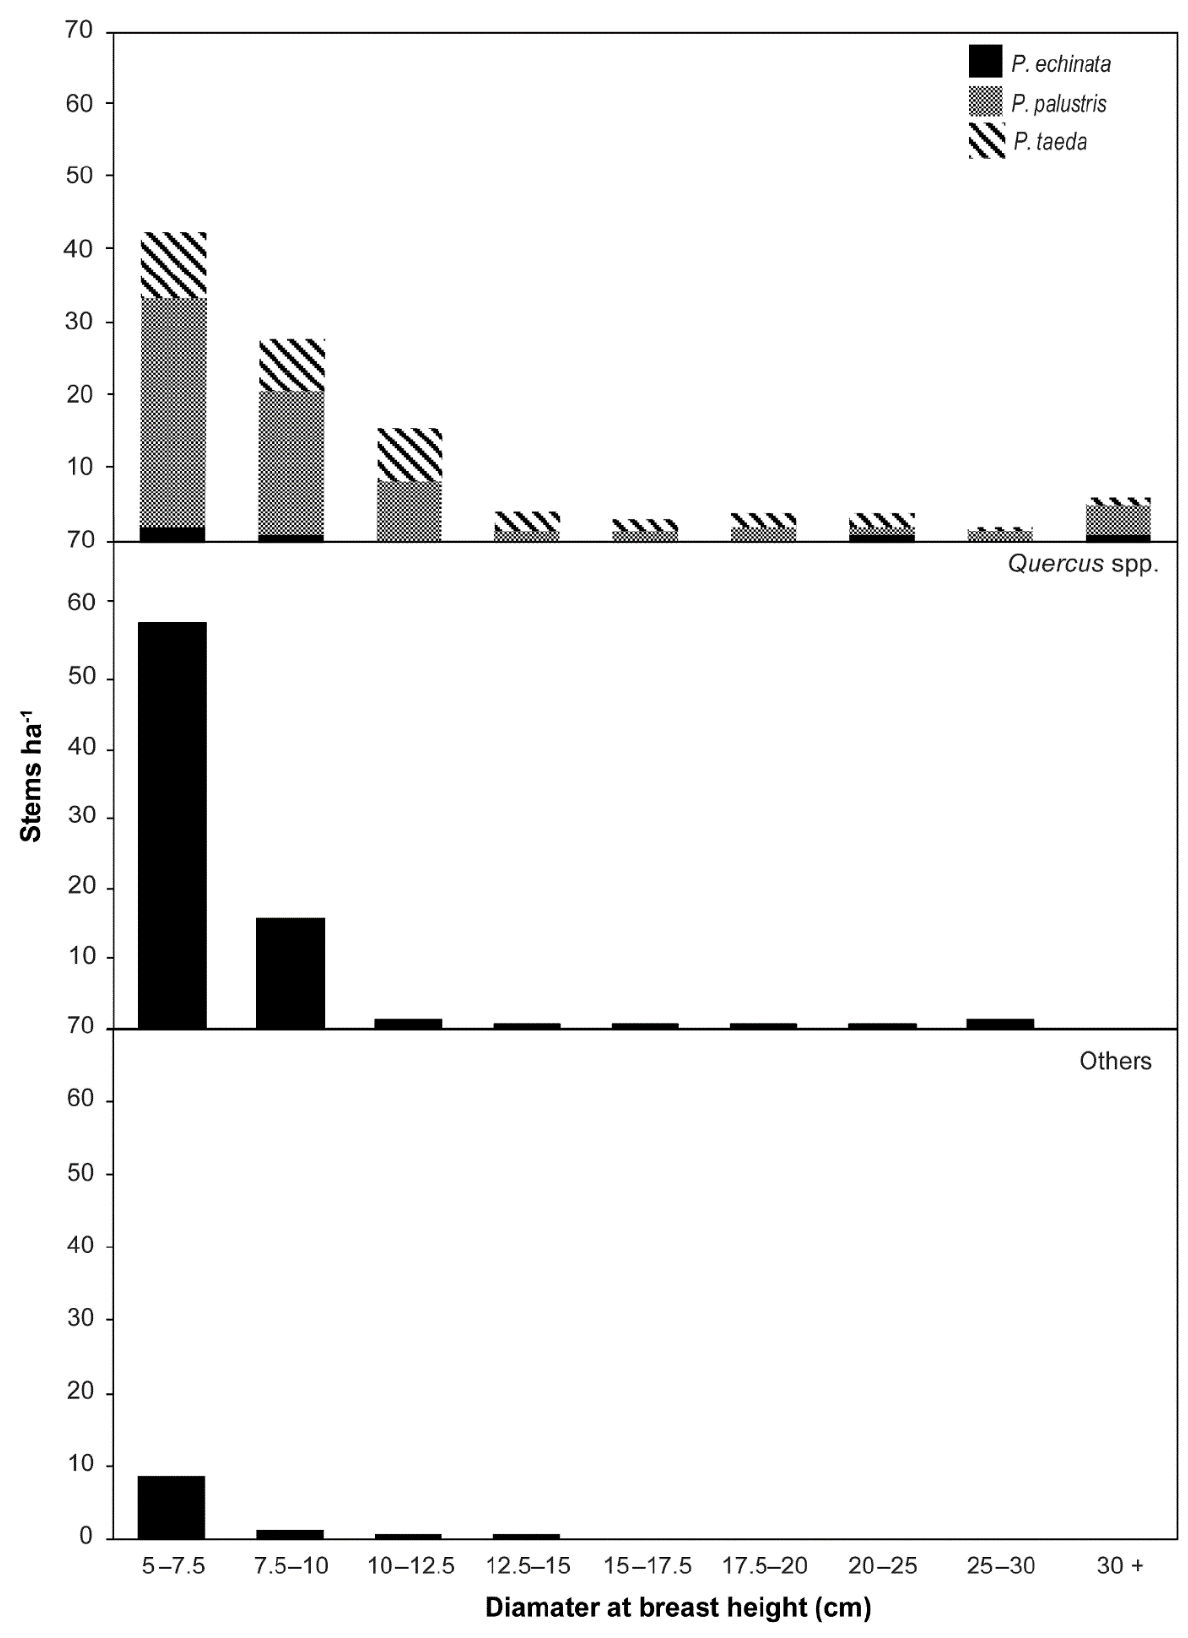
Figure 1. Density (stems ha − 1 ) of trees (live, woody stems ≥ 5 cm dbh) by dbh bins (cm) documented in a catastrophically disturbed Pinus palustris woodland on the Oakmulgee Ranger District, Talladega National Forest, Alabama, USA.